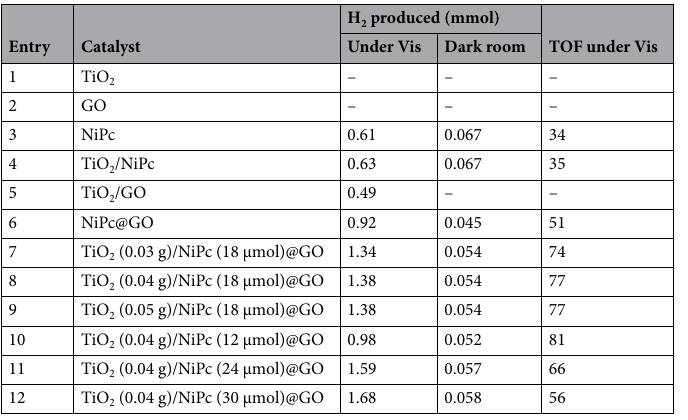
Table 1. H 2 production by various catalysts from FA degradation reaction. Reaction conditions: FA (30 ml), catalyst, r.t., 1 h.